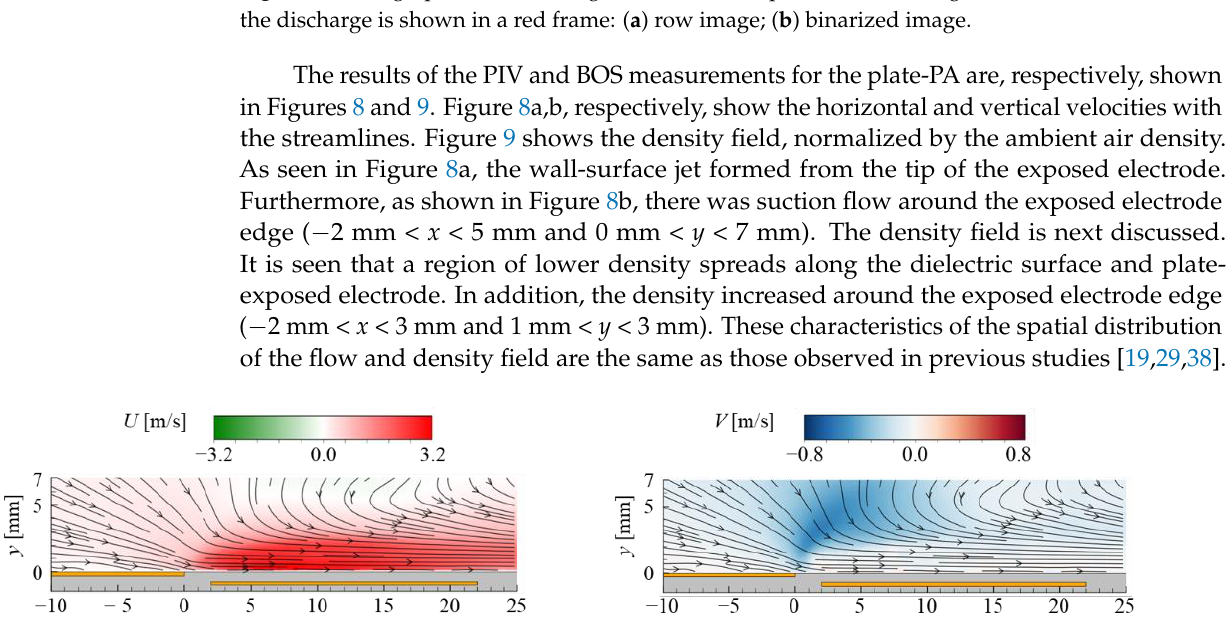
Figure 8. Flow velocity field of the plate-PA, obtained by PIV: ( a ) streamlines and the horizontal velocity; ( b ) streamlines and the vertical velocity.